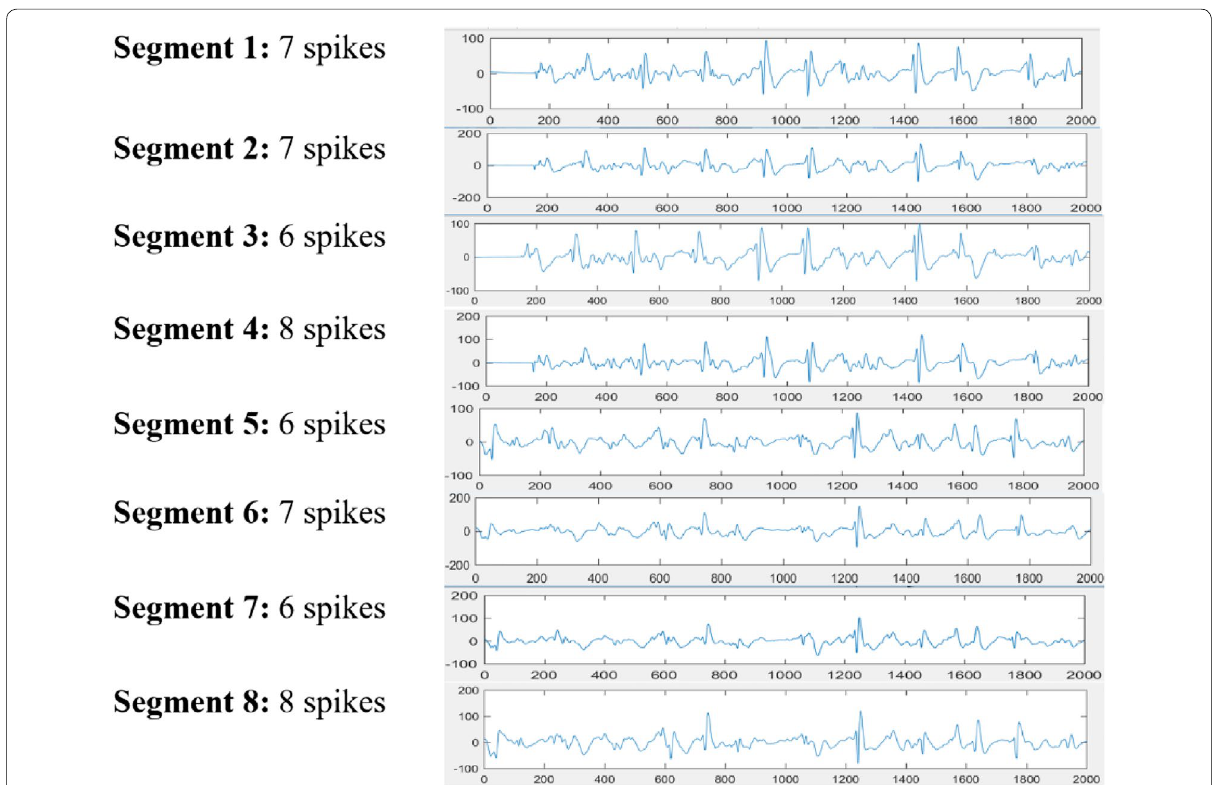
Fig. 5 Description of each